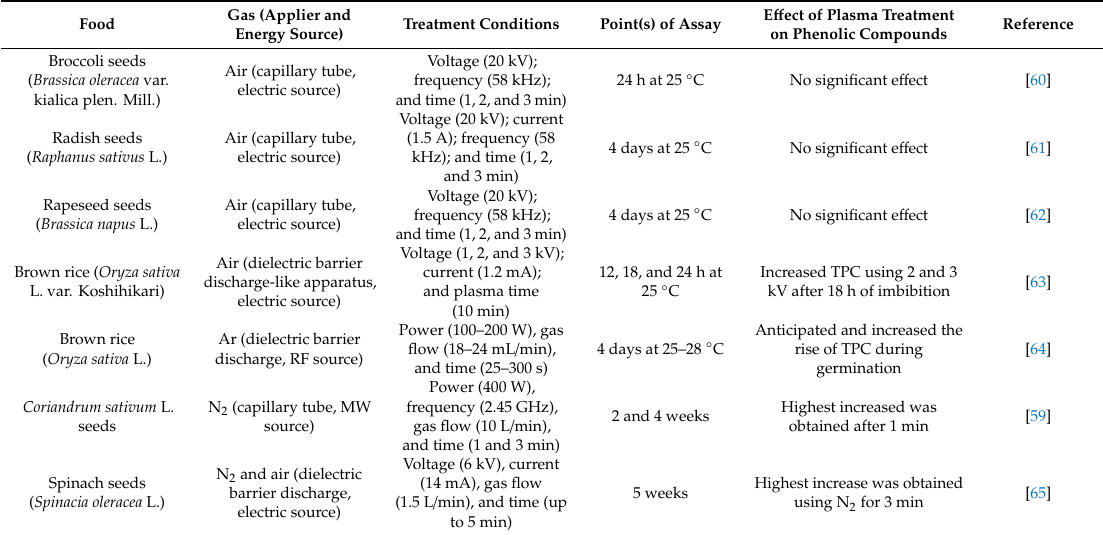
ff ect of Plasma Treatment on Phenolic Compounds Reference